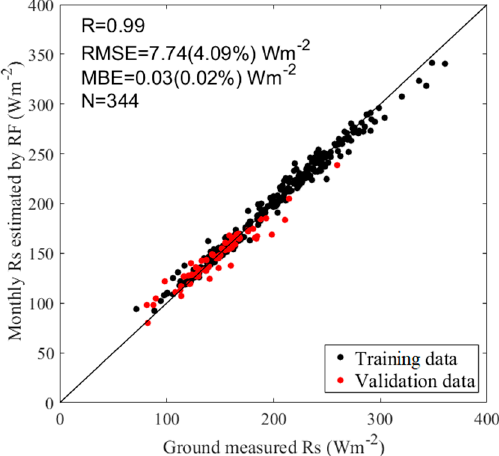
Figure 7. Evaluation results of monthly mean estimated R S data from Himawari-8 AHI data based on the RF method against ground measurements from CDC / CMA from February to May 2016. Estimated R S data are averaged from a 26 km × 26 km window centered at the stations. N is the number of data points.